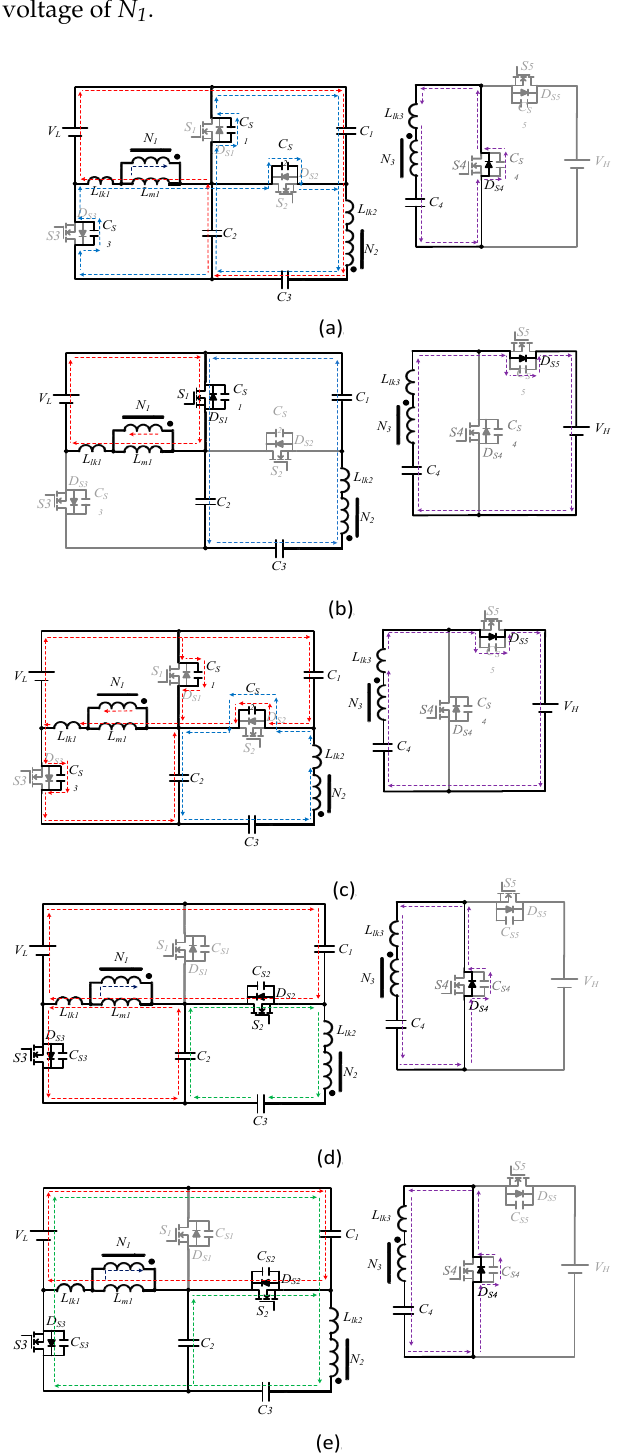
L m1 charges C 4 and L lk3 . Mode 4 ends when the capacitor voltage of C 2 is higher than the voltage of N 1 .